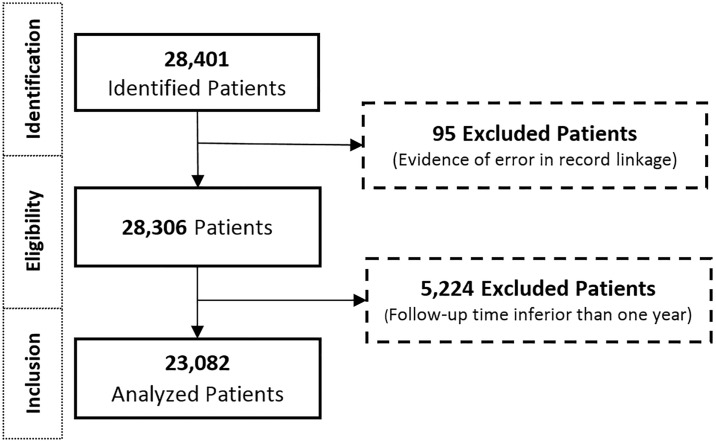
Patient disposition flow diagram.Patient disposition flow diagram showing patients included and excluded from the study cohort.